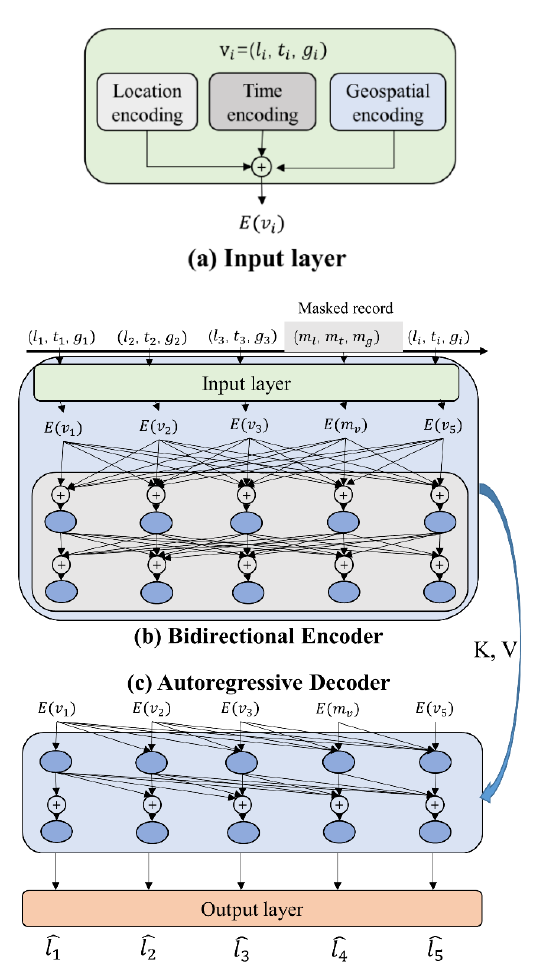
Figure 3 . The sketch map of CASTLE. (a) The input layer of CASTLE consists of the location, time, and geospatial position encoding layer. (b) Bidirectional encoder. (c) Autoregressive decoder.